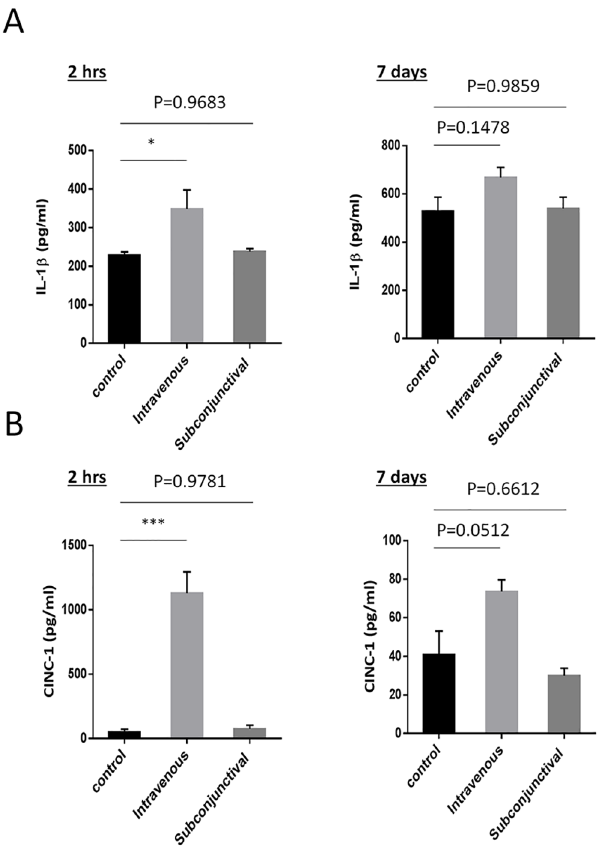
Fig 5. The serum level of IL-1 β and CINC-1 in the rats received a single injection of adenoviral vector via different administration routes. Serum level of interleukin-1 β (IL-1 β ; A) and cytokine-induced neutrophil chemoattractant factor-1 (CINC-1; B) were measured at 2 hours and 7 days after an intravenous or subconjunctival injection of Ad-Luci (1x10 10 GC/eye). Data are presented as the means ± SEM ( * : p < 0.05, *** : p < 0.0001, n = 6). One-way ANOVA followed by a Tukey ’ s test.